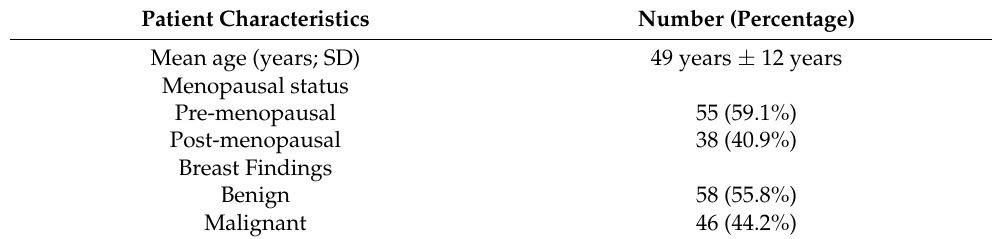
Table 2. Characteristics of the 93 patients included in the analysis.